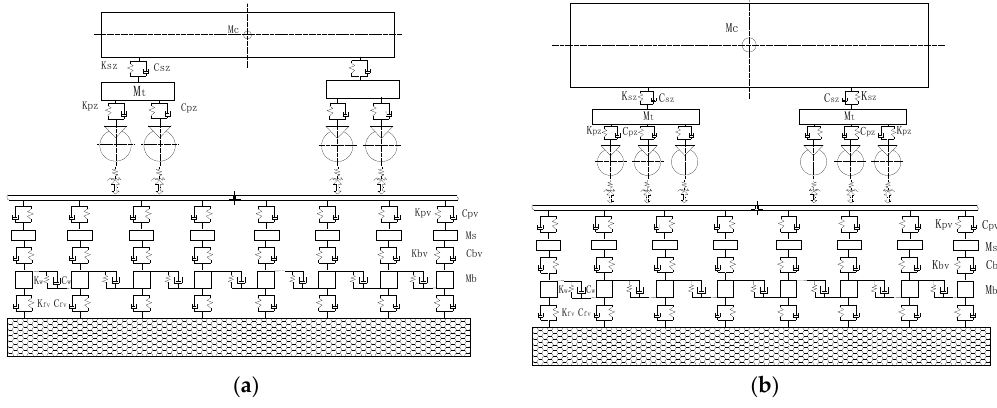
Figure 3. Typical vehicle–track space coupling dynamics model. ( a ) Passenger; ( b ) locomotive.